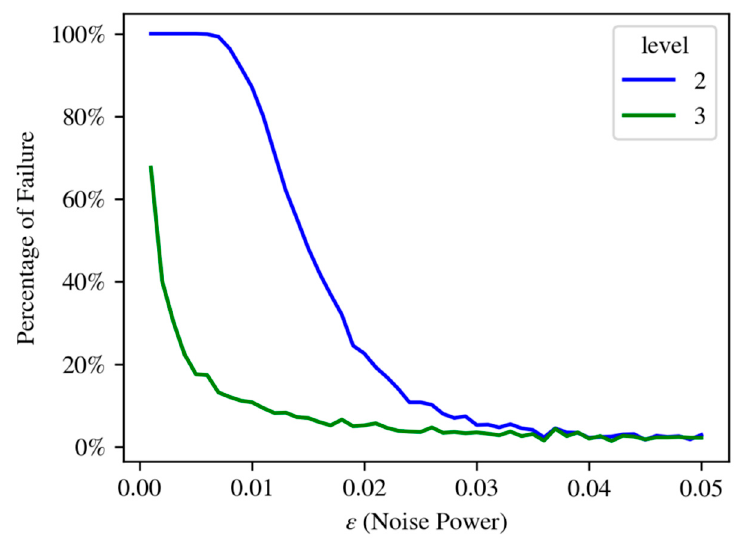
Figure 3. Results of running the configuration of Figure 2 in the GloptiPoly [22] package for PNP. The original configuration failed the second and third levels of the Lasserre hierarchy. Adding uniform noise in [ − ε , ε ] decreases the percentage of failures, but only when the noise reaches 0.04 (which is about 4% of the data’s average size) does the commonly used solution (level 2) succeed with high probability. Similar results were obtained when using the software package in [23].